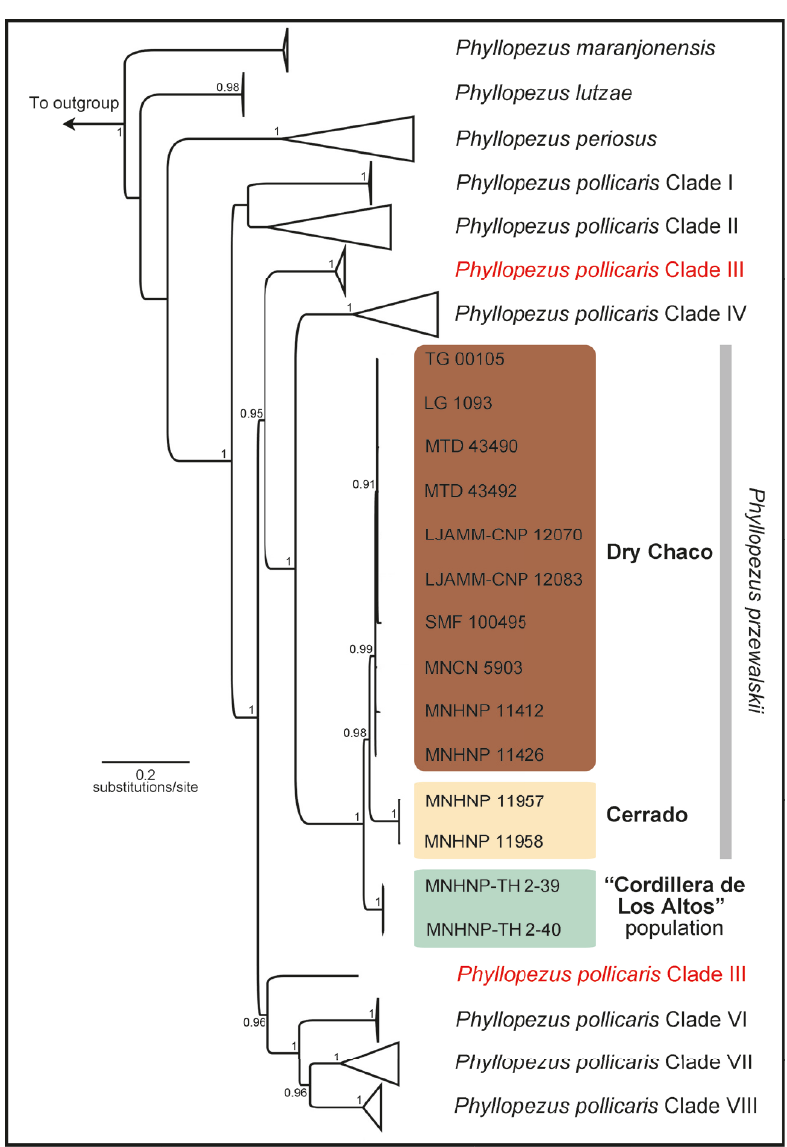
Figure 2: Bayesian tree obtained from concatenated mitochondrial genes (16S, Cytb, and ND2) of the gecko genus Phyllopezus . Numbered clades of P. pollicaris represent the groups recognized by Werneck et al. [11]. Most of clades (with the exception of P. przewalskii ) are collapsed. For details on specimens’ allocation see Figure S8. In red, there is a clade that appears to be polyphyletic. Samples from Dry Chaco are shown in a brown box, those from Cerrado are shown in a yellow box, and in a green box are specimens from “Cordillera de los Altos.” Only PP values higher than 0.9 are shown. Outgroup: Phyllodactylus unctus